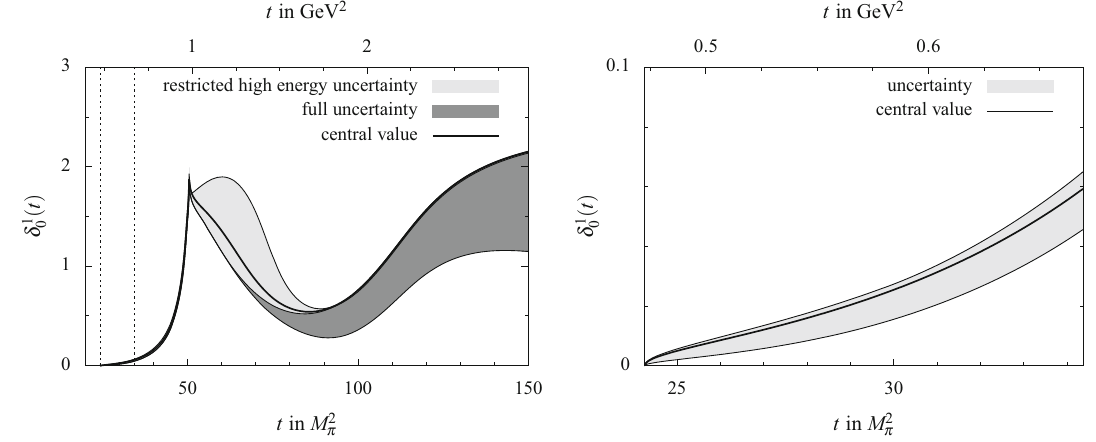
( t ) [41]. In the left Fig. 3 The πη S -wave effective phase shift δ 1 restricted uncertainty band is generated by varying the parameter in the 0 panel , the physical region of the decay η (cid:2) → ηππ is indicated range 105 ◦ ≤ δ 12 ≤ 125 ◦ , while the full uncertainty band is obtained by dashed vertical lines at the threshold t = ( M η + M π ) 2 and at from the parameter range 90 ◦ ≤ δ 12 ≤ 125 t = ( M η (cid:2) − M π ) 2 . The right panel magnifies the physical region. The